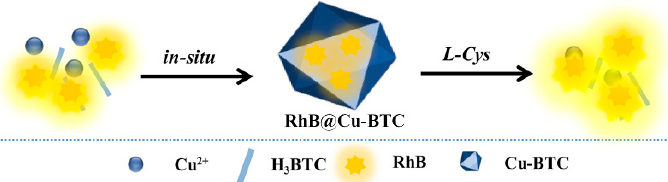
Figure 12. The synthesis of RhB@Cu-BTC and its sensing process for Cys. Reproduced with permission from [102]. Copyright 2018 Elsevier B.V., New York, NY, USA.